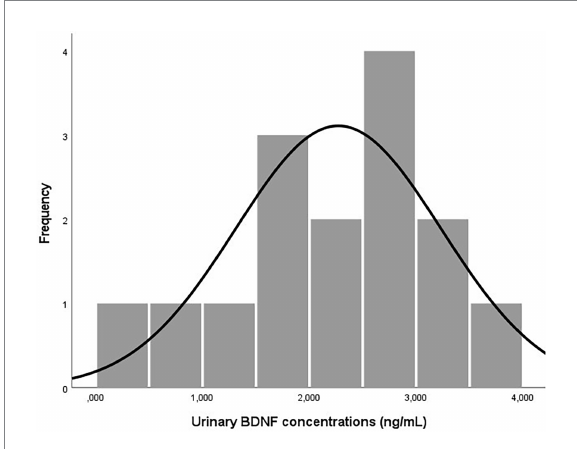
FIGURE 1 Distribution of BDNF concentrations in human urine samples ( n = 15).